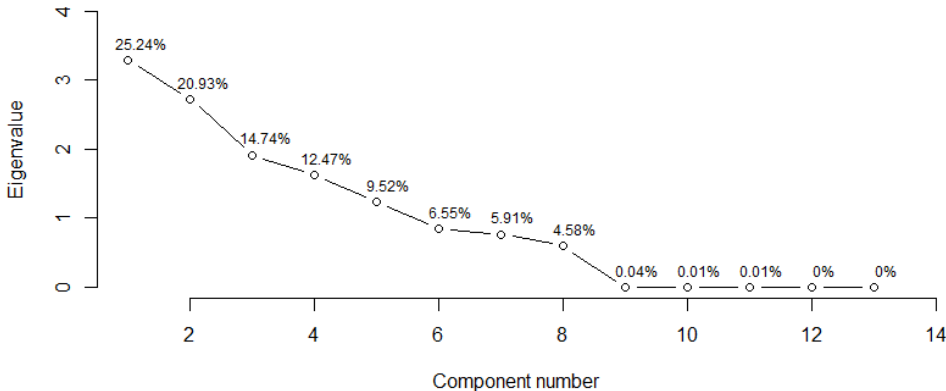
Figure 2. Scree plots of the ordered eigenvalues based on first ‐ stage adult males.